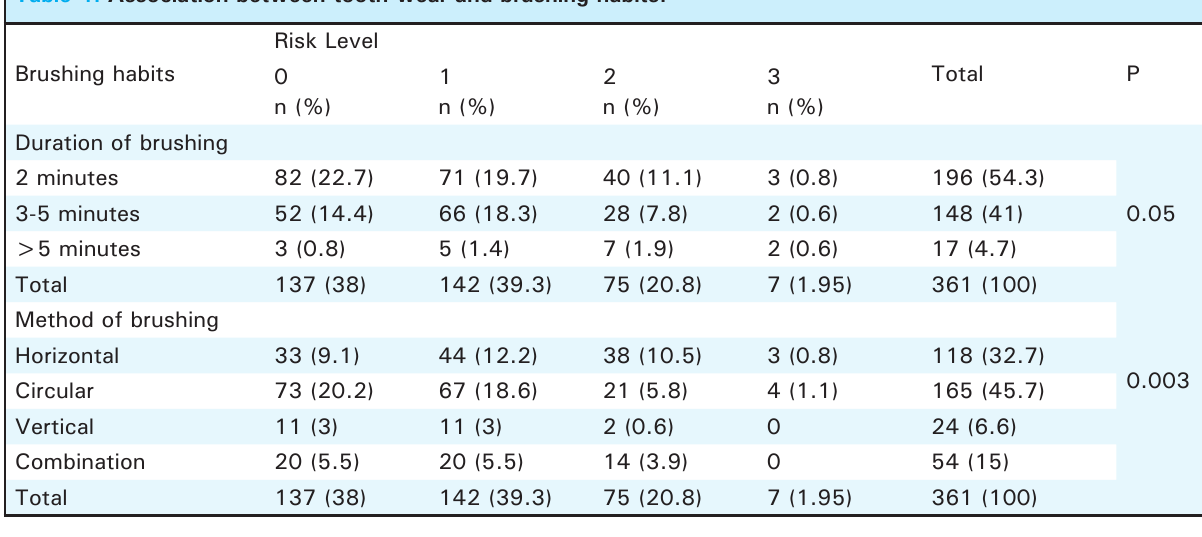
Table 4. Association between tooth wear and brushing habits.